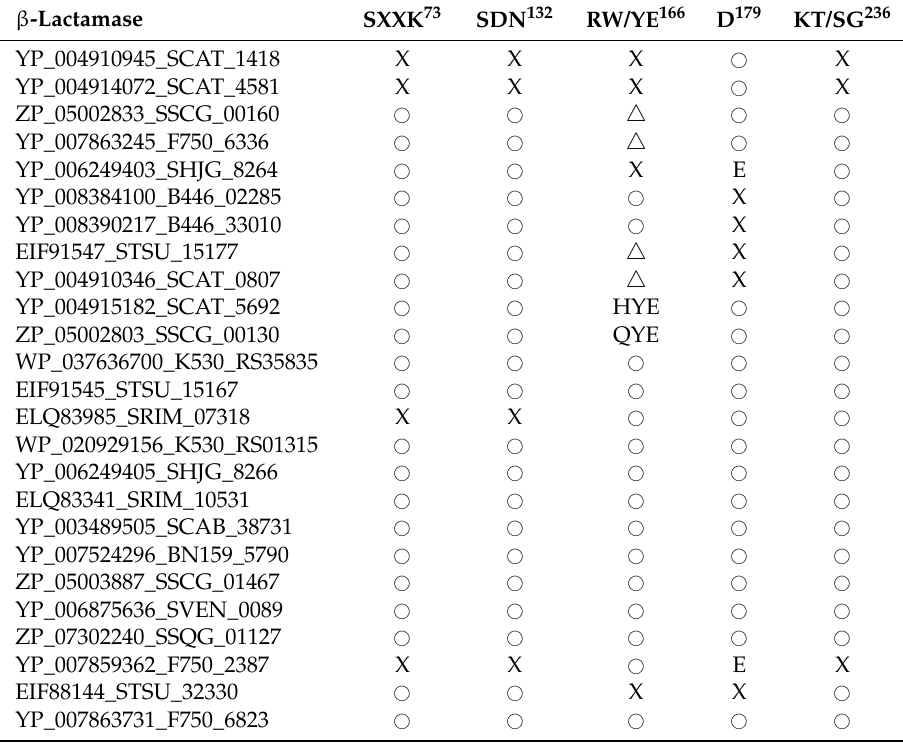
Table 2. Presence or absence of active site residues in class A β -lactamases. β